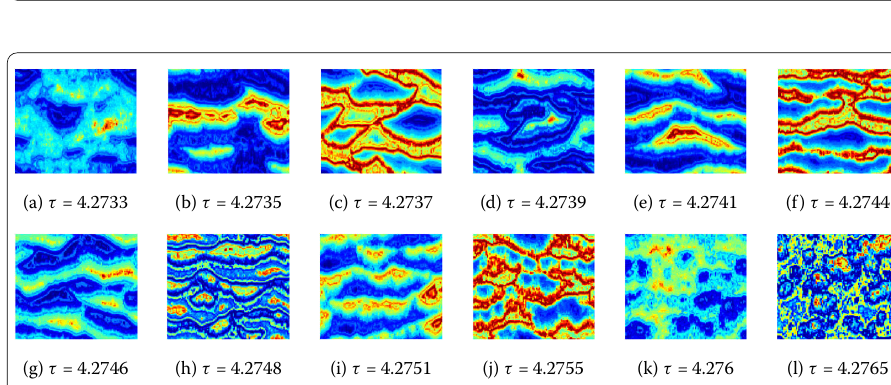
Figure 6 Pattern self-organization and transition with τ value ranging in [4.248,4.292]. Alternation between self-organized structured patterns and disordered states is shown in this range. The conditions for pattern simulations are exactly the same as those in Fig. 3